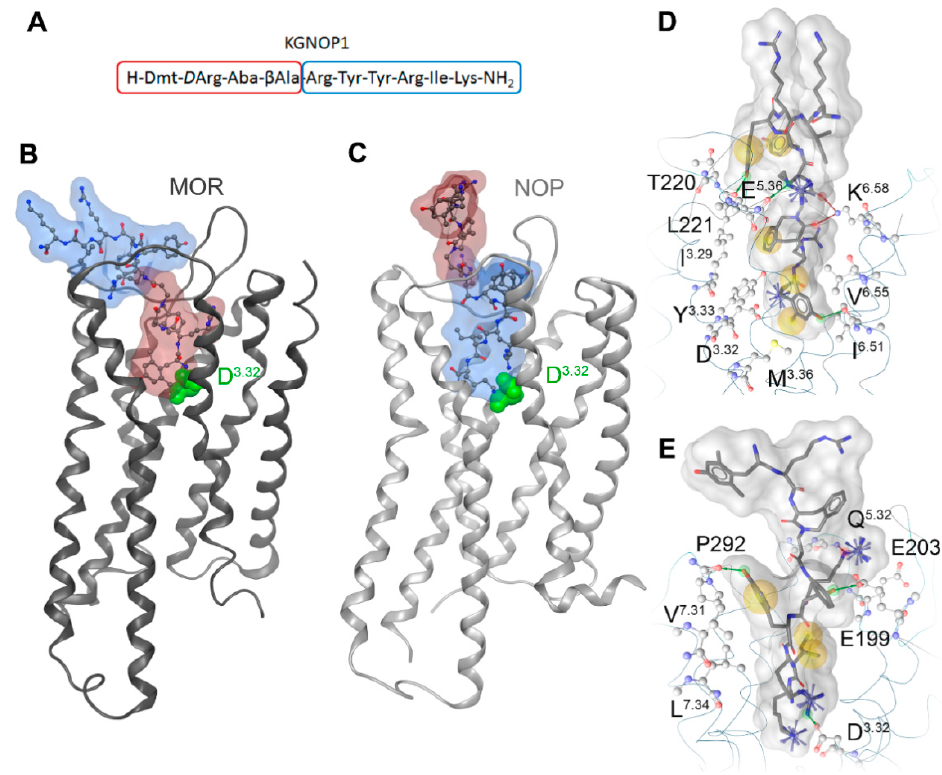
Figure 5. Proposed binding modes of KGNOP1 ( A ) to the active state of the MOR (( B ); PDB entry 6DDF, chain R) and the inactive conformation of the NOP receptor (( C ); PDB entry 5DHG, chain A). The bifunctional peptide KGNOP1 consists of a MOR-binding scaffold and a substructure binding to the NOP receptor (red and blue surface, respectively; A – C ). These receptor-specific peptide parts bind in opposing orientations to the inner core region of both receptors driven by a charge interaction with D 3.32 (green). A more detailed interaction pattern is visualized in ( D ) for the MOR-KGNOP1 complex and ( E ) for the NOP receptor-KGNOP1 complex, by illustrating hydrophobic contacts as yellow spheres, positively ionizable centers as blue stars and hydrogen bond acceptors and donors as red and green arrows, respectively.